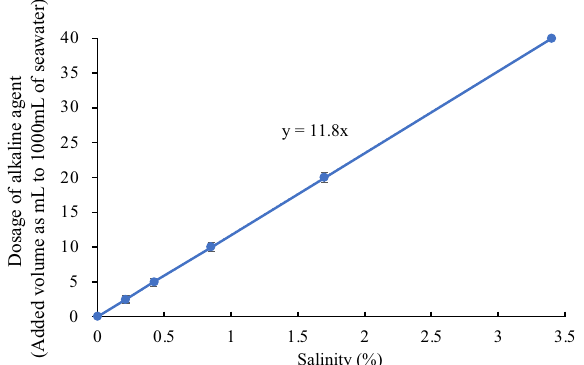
Fig. 4 Floc settling velocity versus fl occulent dosage for different polymer fl occulants in softening with ballasted fl occulation (SBF) of arti fi cial seawater ( n = 3, means ± standard deviations). Six types of anionic polymers (AP199, AP335B, AP825B, AP335PWS, AP120PWS, and AP410PWS) and one nonionic polymer (NP800PWS) were